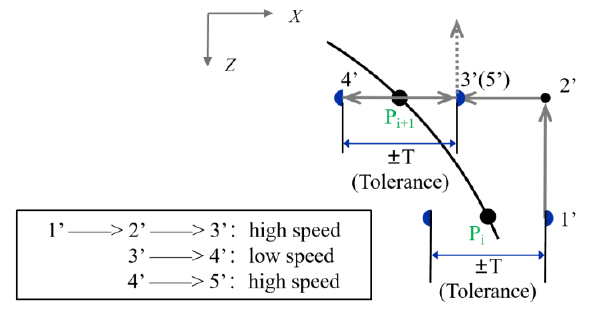
Figure 4. Sampling trajectory planning for two adjacent points.